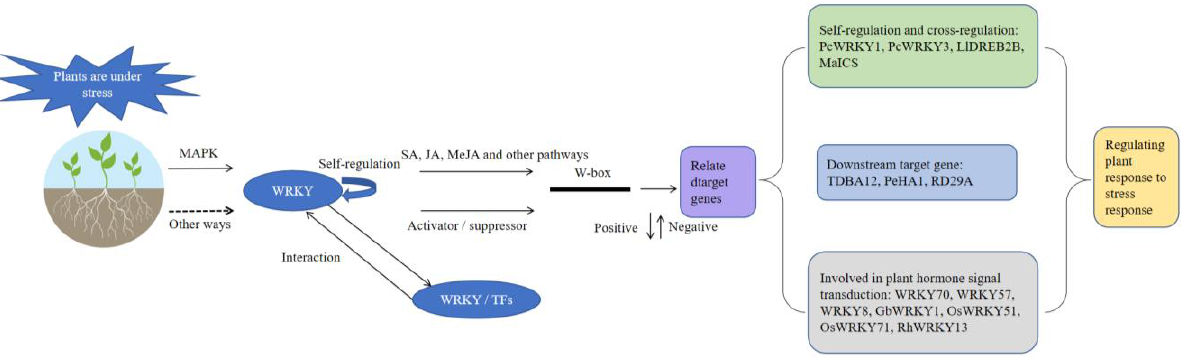
Figure 3. Mechanism underlying the regulatory effects of WRKY transcription factors on plant stress responses.